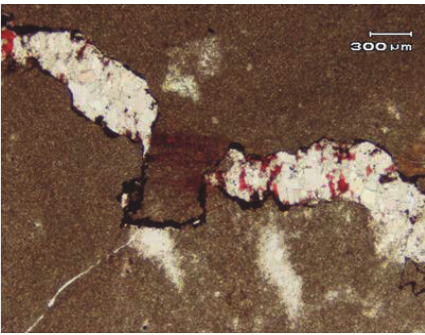
Figure 13: Gypseous dolomicrite, S3, 2361.56 ∼ 2361.72 m, T 1 j 2 .